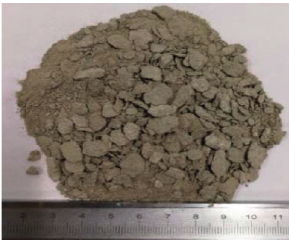
Figure 22: Conventional PDC bit.